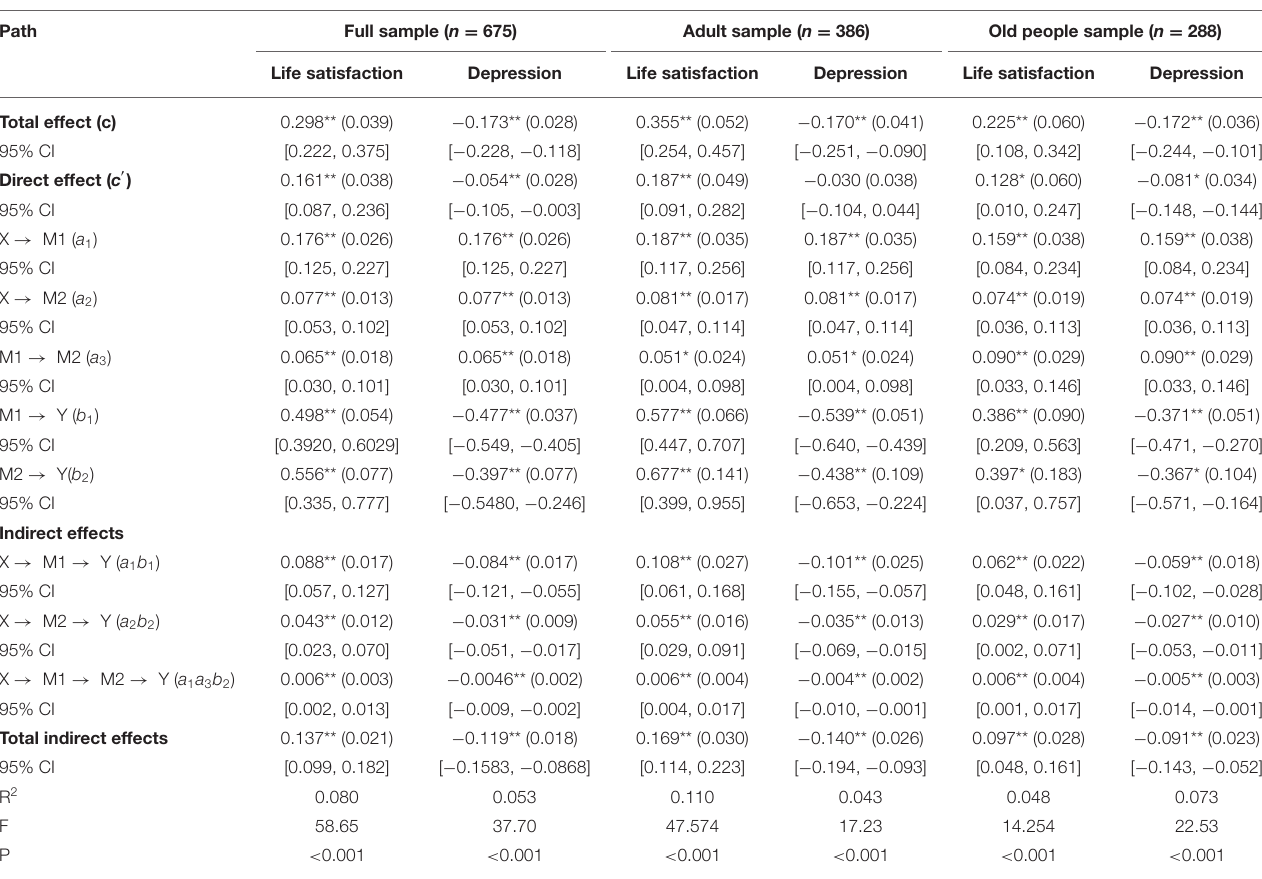
TABLE 3 | Path coefficients and standard errors from serial mediation models estimated using process.